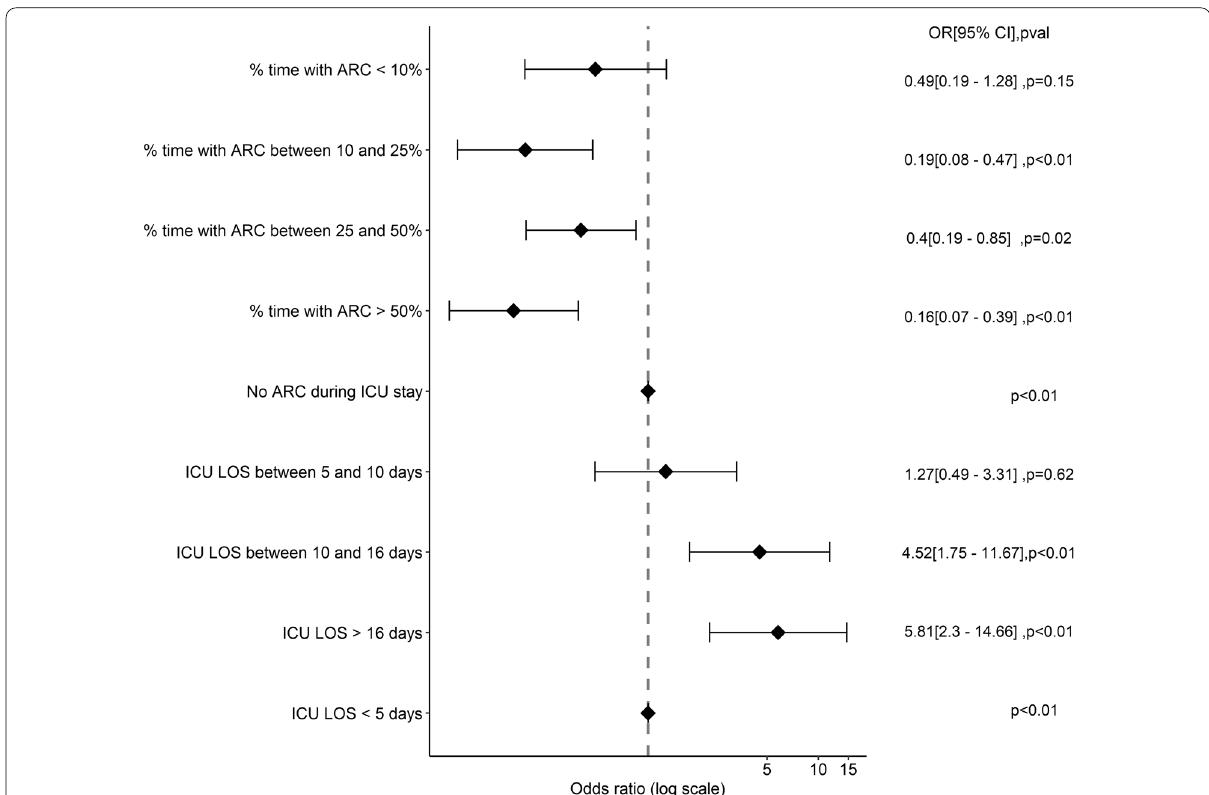
Fig. 5 Association between the percentage of time with ARC (augmented renal clearance) during ICU (intensive care unit) stay and ICU mortality (multivariate logistic regression model), LOS (length of